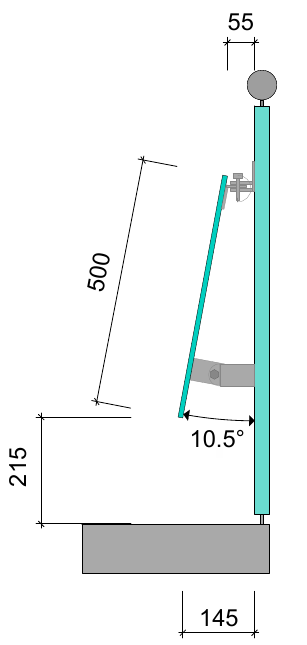
Figure 2. Details of the sloped wall in the pen. The angle between the solid wall and the sloped wall is given, and the other measures are given in centimetres.